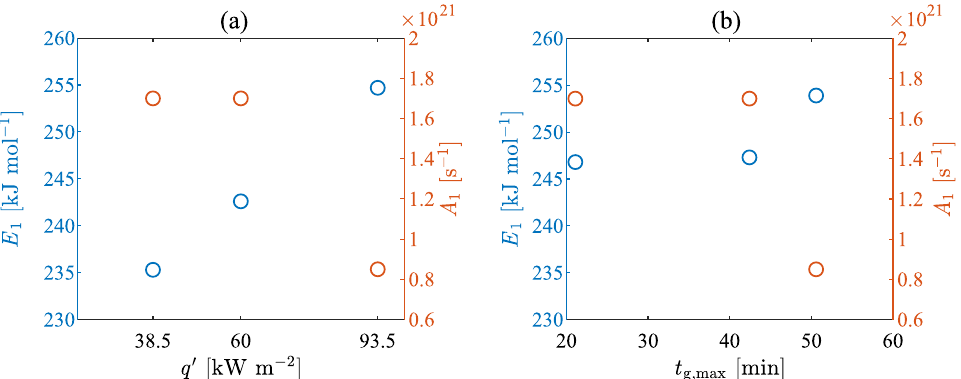
Fig. 14 A relationships between the parameters E 1 and A 1 and a the external heat flux exposure in cone calorimeter tests, and b time t g,max for fire scenarios 1, 2 and 3 in case of natural fire tests of CLT floor